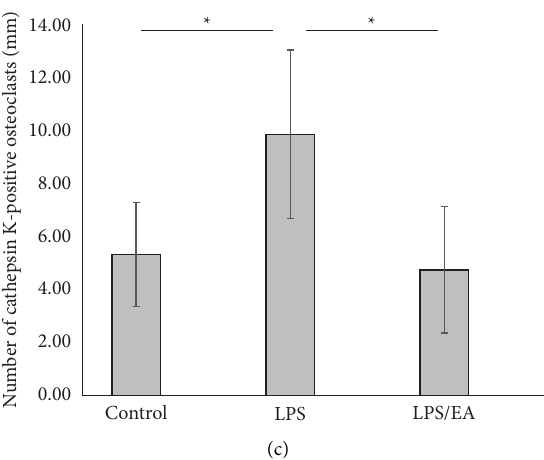
Figure 1: Efect of Equisetum arvense extract (EA) on lipopolysaccharide (LPS)-induced osteoclast formation. Efects of EA (15 μ g/mL) on osteoclast formation by Escherichia coli ( E . coli )-LPS (5mg/mL). Periodontal tissue was collected 3 days following treatment, and immuno- histochemical (IHC) staining was performed. (a) Illustration of the osteoclast counting area. (b) Immunoexpression of cathepsin K, an osteoclast marker after 3 days following (A, A ′ ) physiological saline (control), (B, B ′ ) E . coli -LPS, and (C, C ′ ) E . coli -LPS/EA application. Scale bars � 100 μ m. (c) Te number of cathepsin K-positive osteoclasts formed along the alveolar bone margin within 1mm of the alveolar crest is counted. Data are presented as means ± standard deviation ( n � 7 for each group). Tukey–Kramer multiple comparison test, ∗ p < 0 .